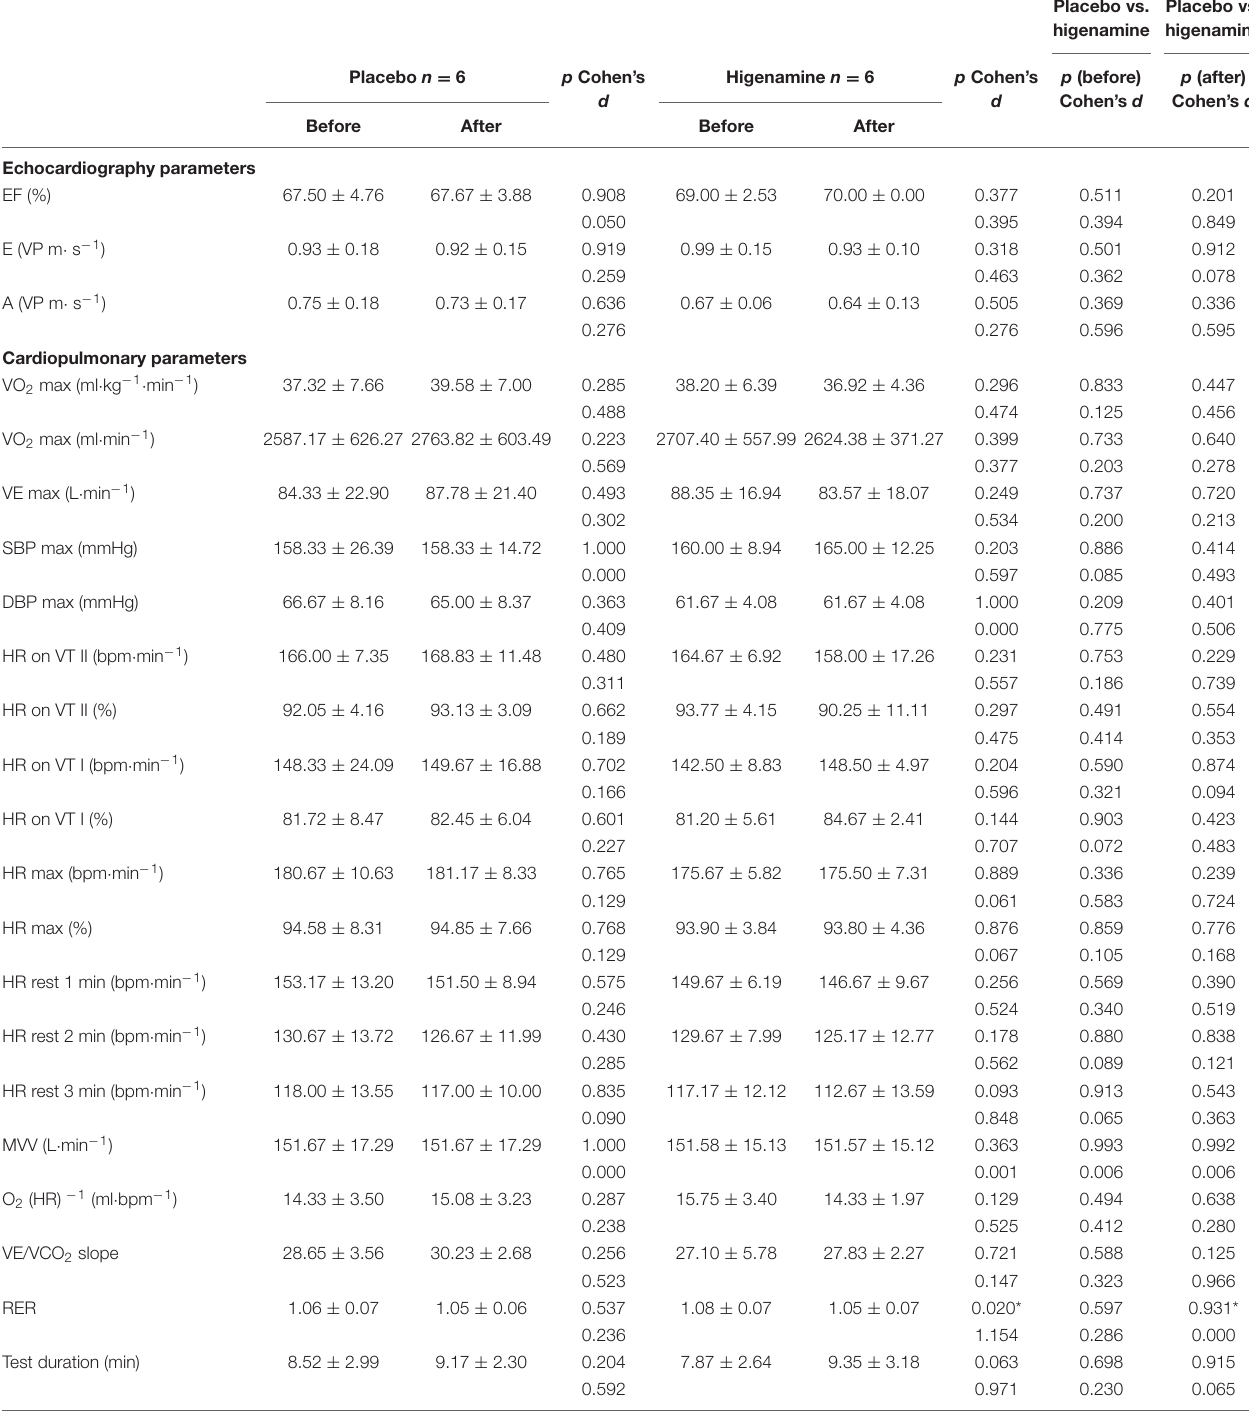
TABLE 4 | Cardiopulmonary and echocardiography parameters in placebo and higenamine groups before and after the treatment.